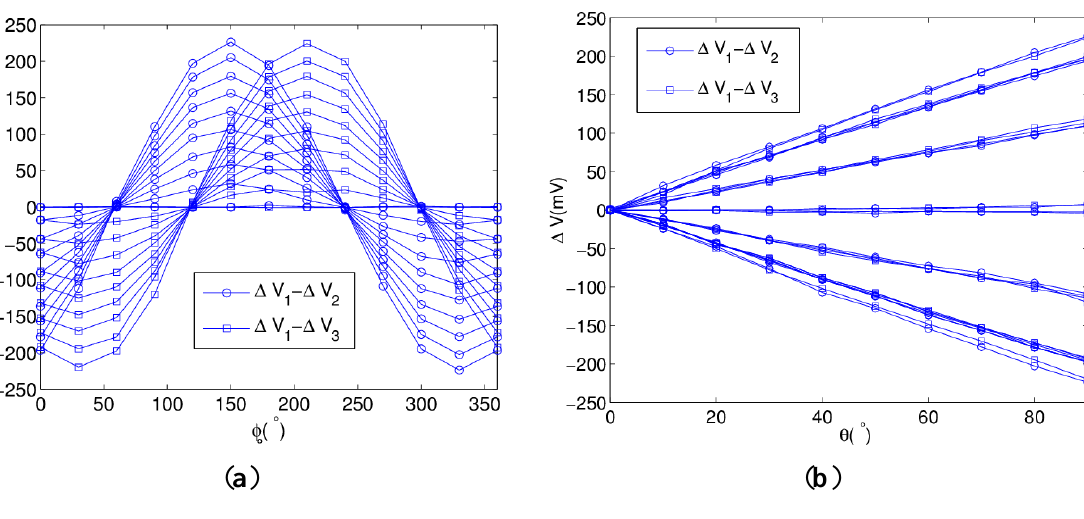
Figure 7. Analysis of sensor outputs ( a ) Characteristic of ∆ V Sinusoidal relation with orientation; ( b ) Characteristic of ∆ V